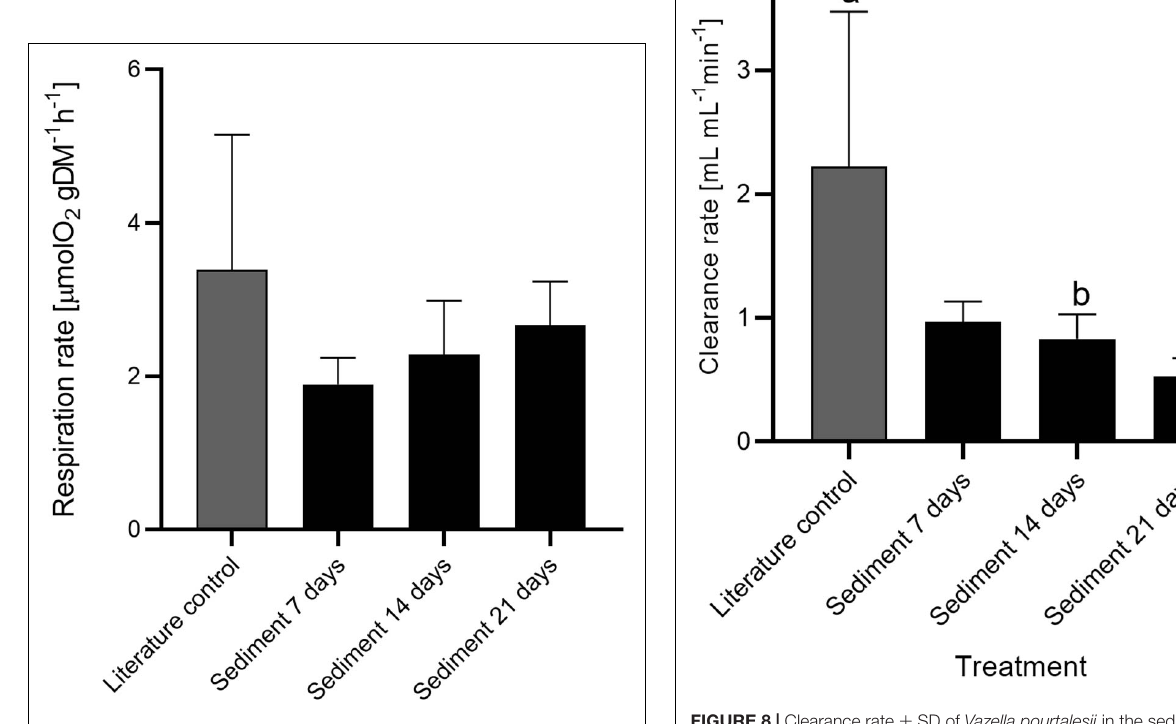
FIGURE 8 | Clearance rate ± SD of Vazella pourtalesii in the sediment treatment group over time compared to a literature control (Bart et al., 2020). Pairs of letters (ab) indicate 2 cm significant differences ( p < 0.05) among means ( n = 5 per sediment treatment and n = 7 for literature control). Common letters indicate that no significant difference was